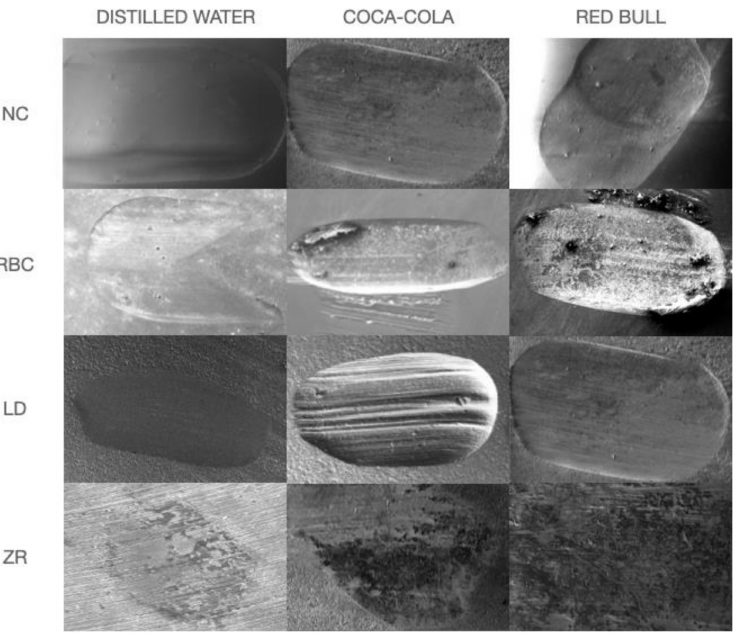
Figure 1. Representative scanning electron microscope images of the study specimens. It is evident how specimens immersed in acidic pH beverages during chewing simulation showed a different worn surface from water-immersed ones. All materials showed a rough surface with grooves oriented parallel with the sliding direction, indicating an abrasive wear mechanism. ZR revealed wear pits associated with the dislodgment of ceramic particles on the worn surfaces of the zirconia